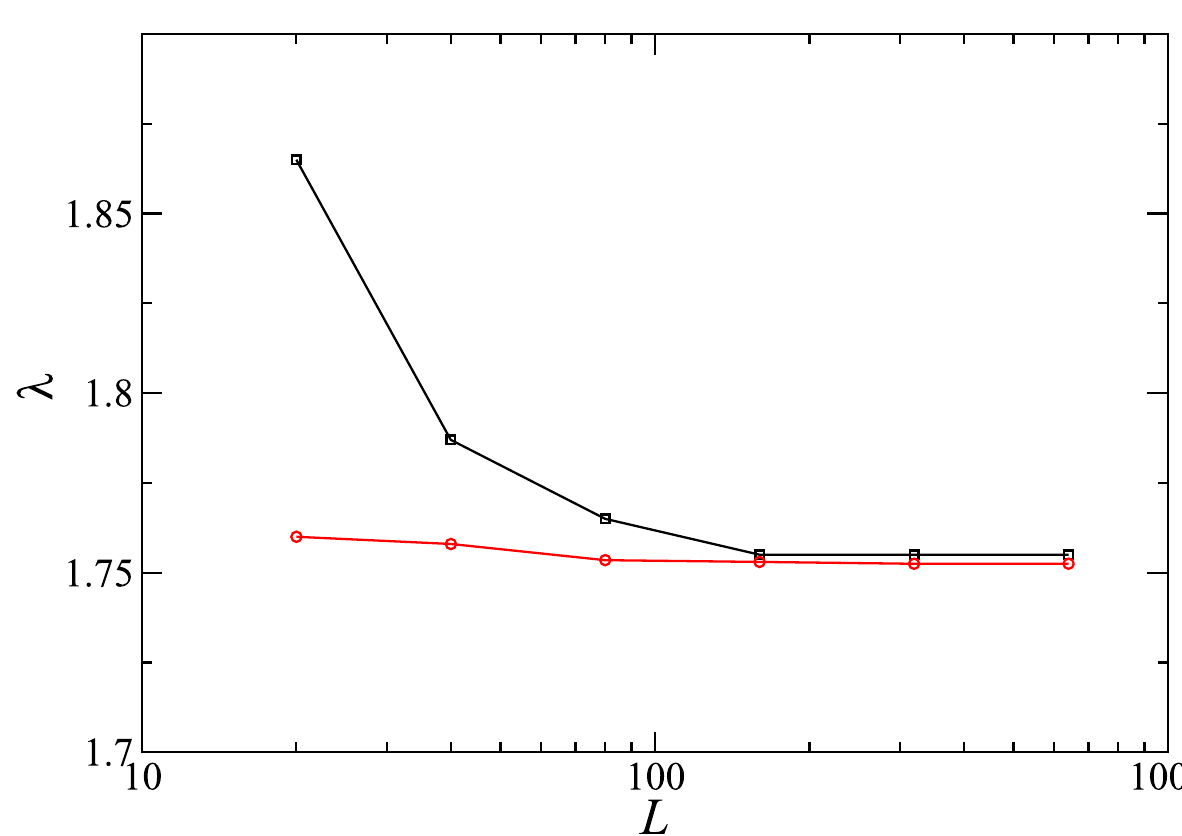
Fig 15. (Color online) Boundaries of the SS regime in the λ — L plane for α = 0.1. The lower boundary corresponds to the pseudocritical point, λ c ( L